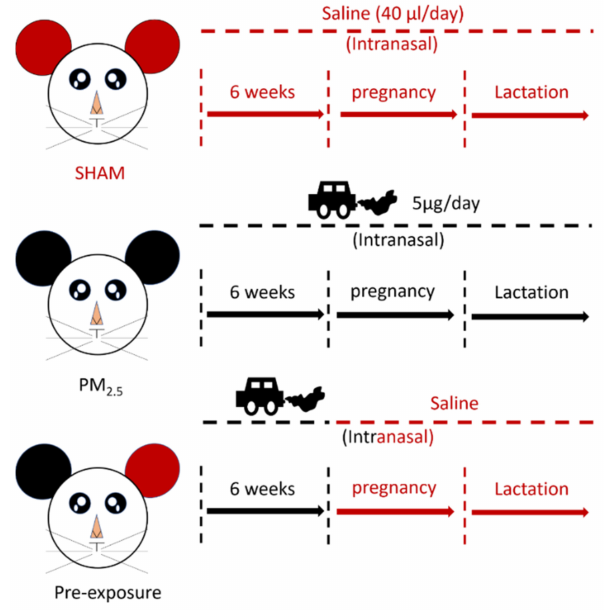
Figure 1. Flow chart of maternal